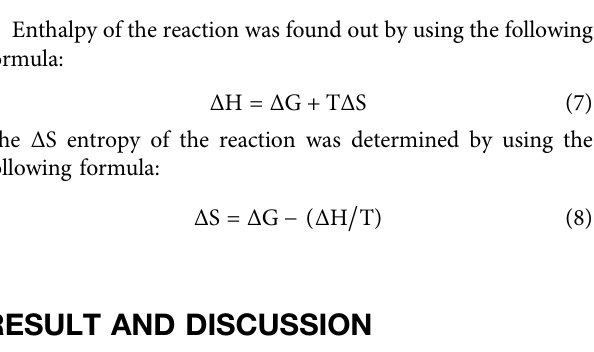
Frontiers in Environmental Science |